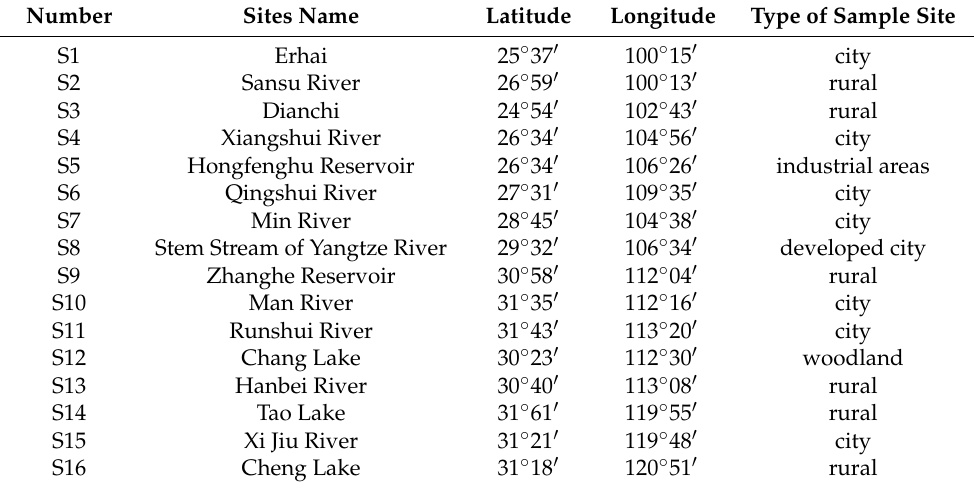
Table 2. Geographical information and site types for the 16 sampling sites on the Yangtze River